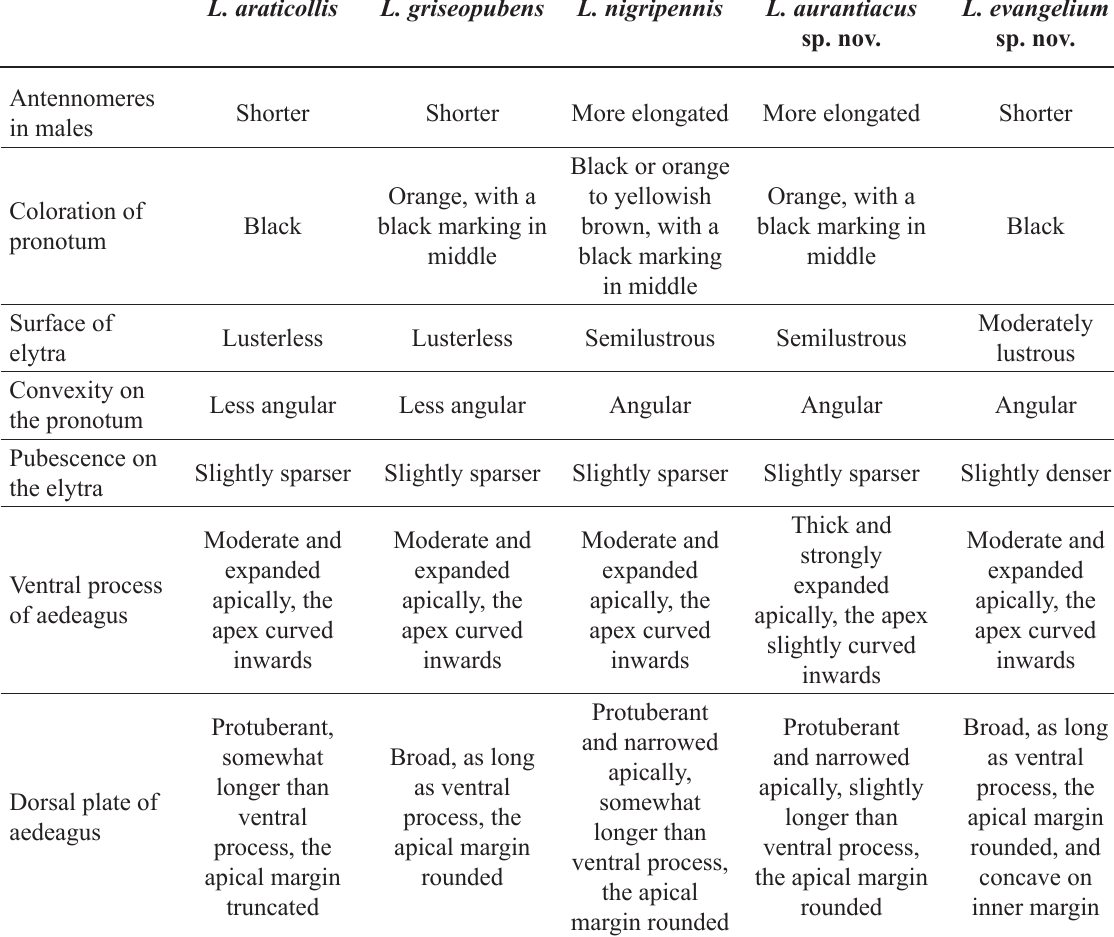
Table 3. Diagnostic characters of L. nigripennis (Pic, 1938) and similar